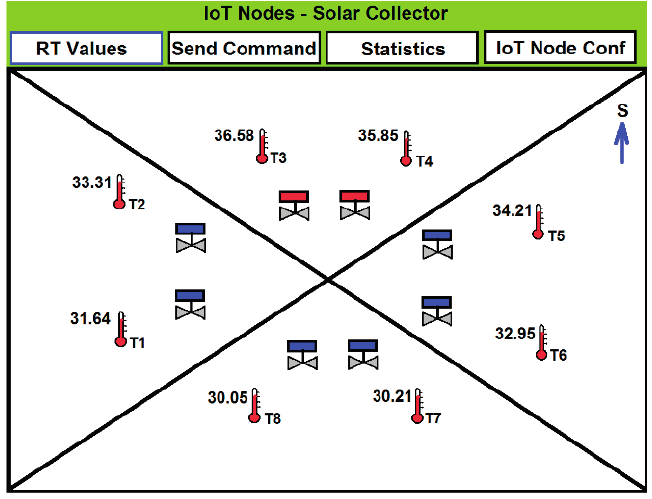
Figure 14. M3 type IoT node light web server